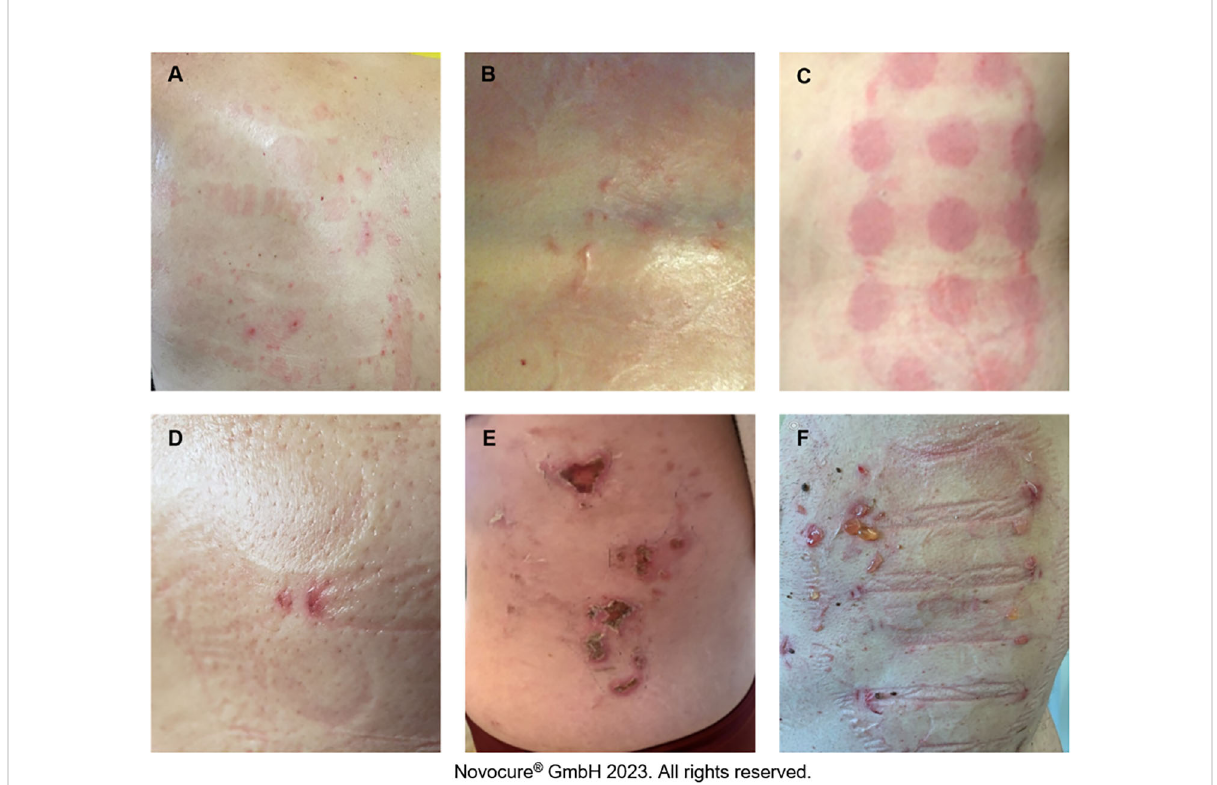
FIGURE 2 Potential TTFields therapy-associated skin AEs. Pruritus (A) , hyperhidrosis (B) , contact dermatitis (C), skin erosion (D) , pressure necrosis (E) , contact dermatitis and infection (F)